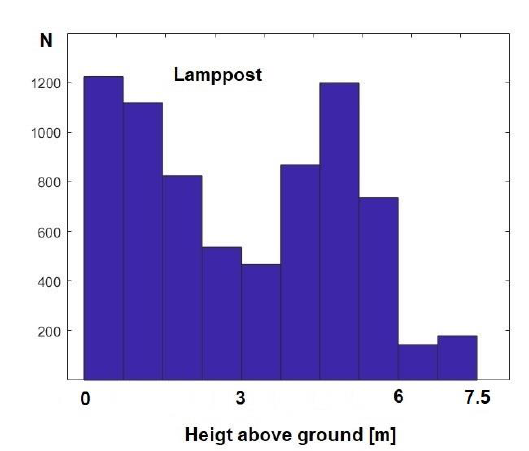
Figure 9. Histogram of the number of points present within a lamppost tile of 50x50cm (see red arrow in Figure